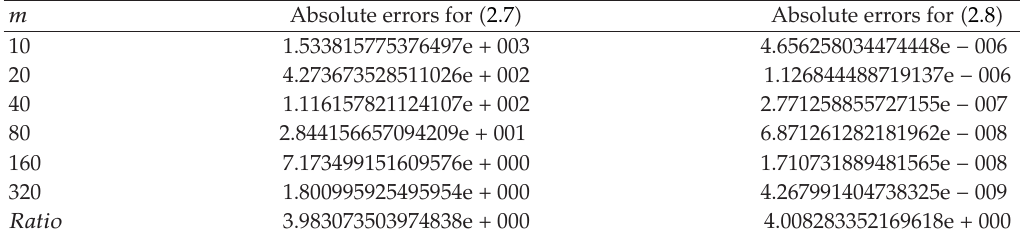
Table 6: Equation (cid:6) 4.13 (cid:7) in case of mid-point rule for (cid:6) 2.7 (cid:7) and (cid:6) 2.8 (cid:7)